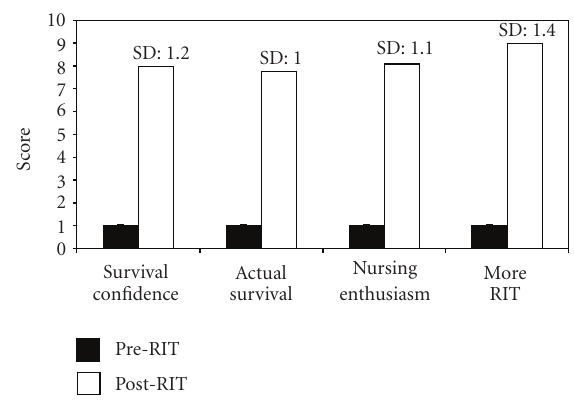
Figure 2: Impact of RIT on nursing practice experience from 9 hospitals centres; survey results with normalised prescores of 1 and postscores out of 0 to 10, n = 79 respondents.